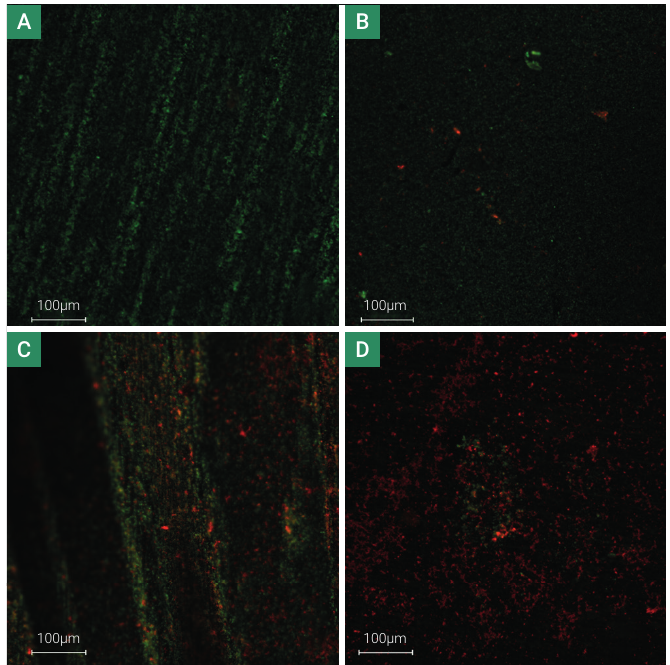
Figure 4. Representative images of scores found for both materials after staining using Live/Dead BacLight bacterial viability and cell counting method. Viable/Live bacteria stained in green and Dead bacteria stained in red. (A) Hybrid ceramic treated with diamond bur (ENDB); (B) Hybrid ceramic polished with Dedeco system (ENDD); (C) Nano ceramic resin composite treated with diamond bur (LVDB); and (D) Nano ceramic resin composite polished with Dedeco system